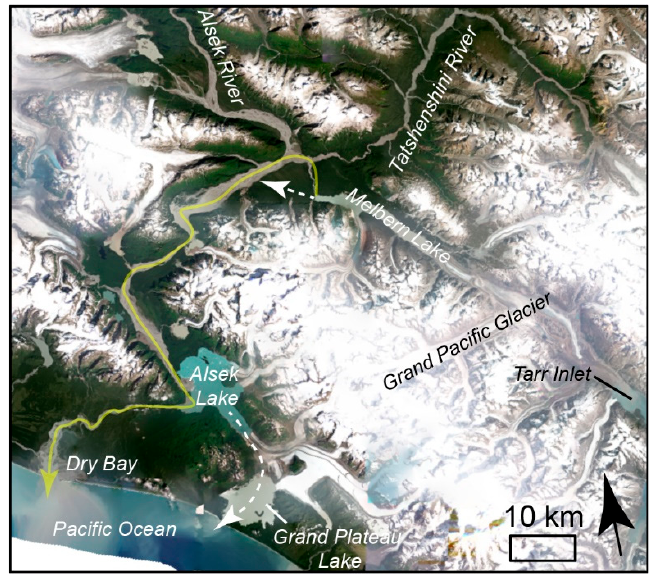
Figure 4. Satellite image mosaic of possible drainage changes in the lower Alsek River valley and Melbern valley. Yellow line shows the current drainage routes; dashed white lines indicate possible future drainage paths described in the text. Background image is an August 2021 satellite mosaic from Planet, and projection is Alaska Albers Equal Area Conic.